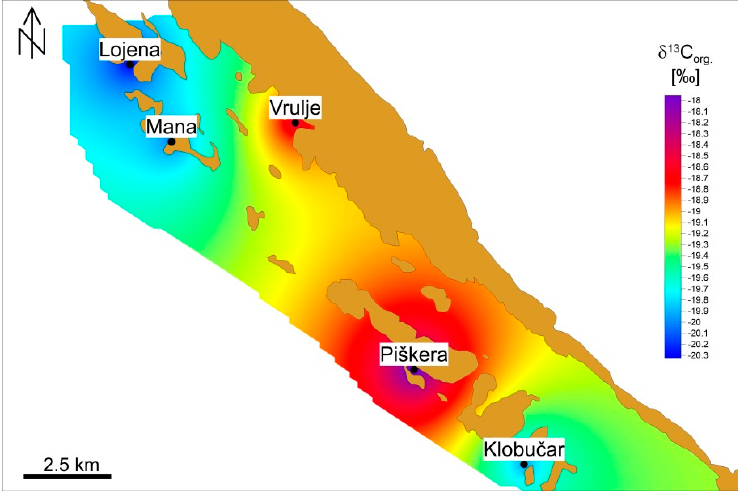
Figure 3. Distribution map of the δ 13 C org values of the sediment.